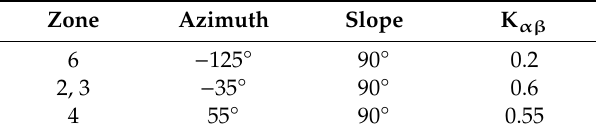
Table 2. Correction factor for the surface’s azimuth and slope.